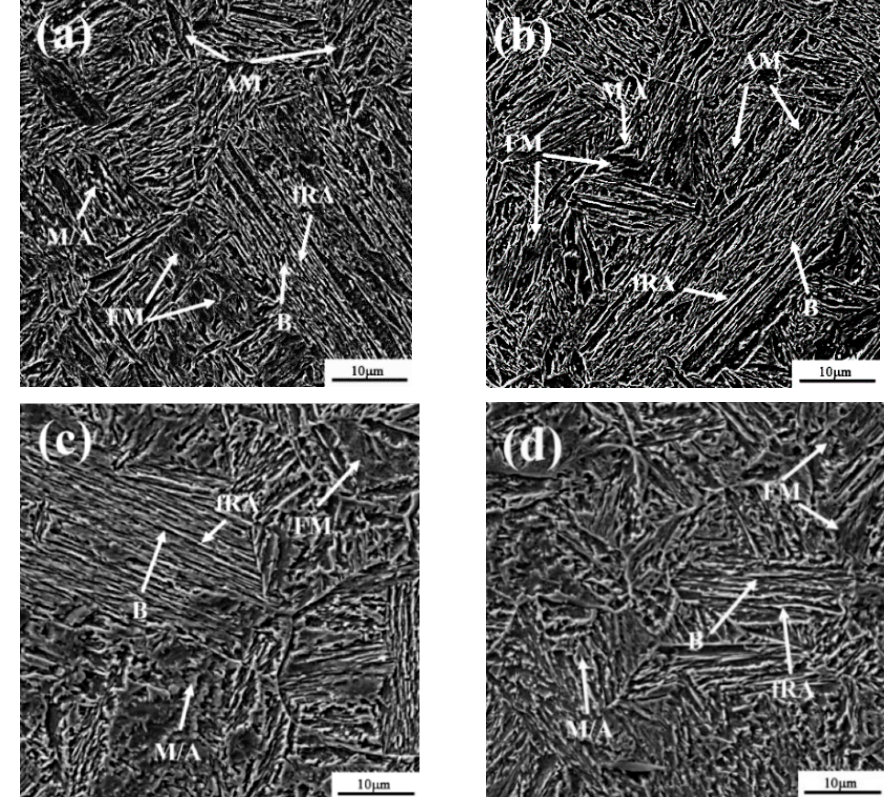
Figure 6. SEM micrograph of different samples: ( a ) B200, ( b ) B400, ( c ) A200 and ( d ) A400.